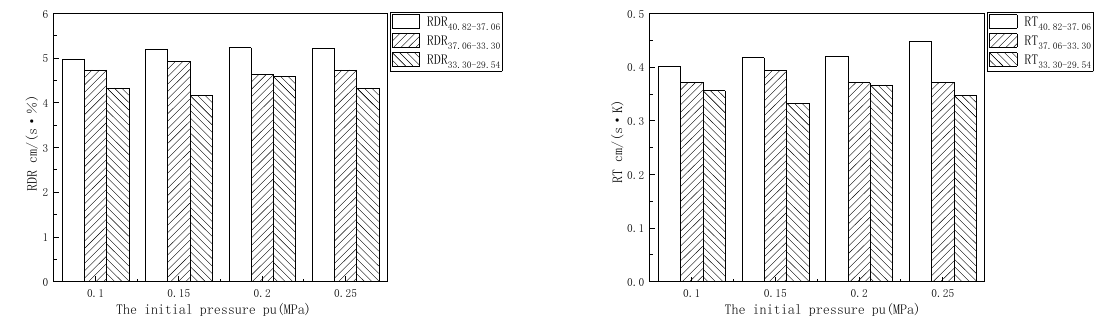
Figure 12. The rate of change R of the u L corresponding to the Pu. Figure 13 shows the equivalent distribution pattern of u L under the coupling effect of Tu and DR when Φ is 1.0 and when the range of the initial temperature is 348–423 K. The figure indicates that u L gradually decreases from the low-pressure and low-dilution rate area to the high-pressure and high-dilution rate area. When the initial temperatures are 348 K, 373 K, 398 K and 423 K, the ranges of u L are 15.50–46.80 cm/s, 17.80–52.60 cm/s, 20.2–58.8 cm/s and 22.8–65.4 cm/s. With the increase in initial temperature, the variations in u L are 31.3 cm/s, 34.8 cm/s, 38.6 cm/s and 42.6 cm/s, respectively, exhibiting a gradually